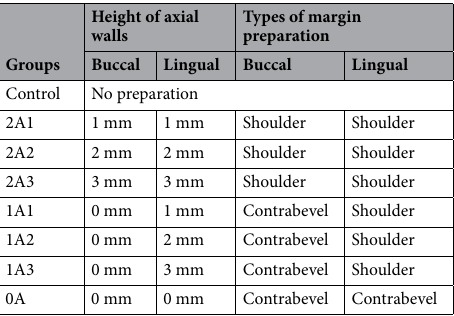
Table 1. Characteristics of the various preparation designs in this study.